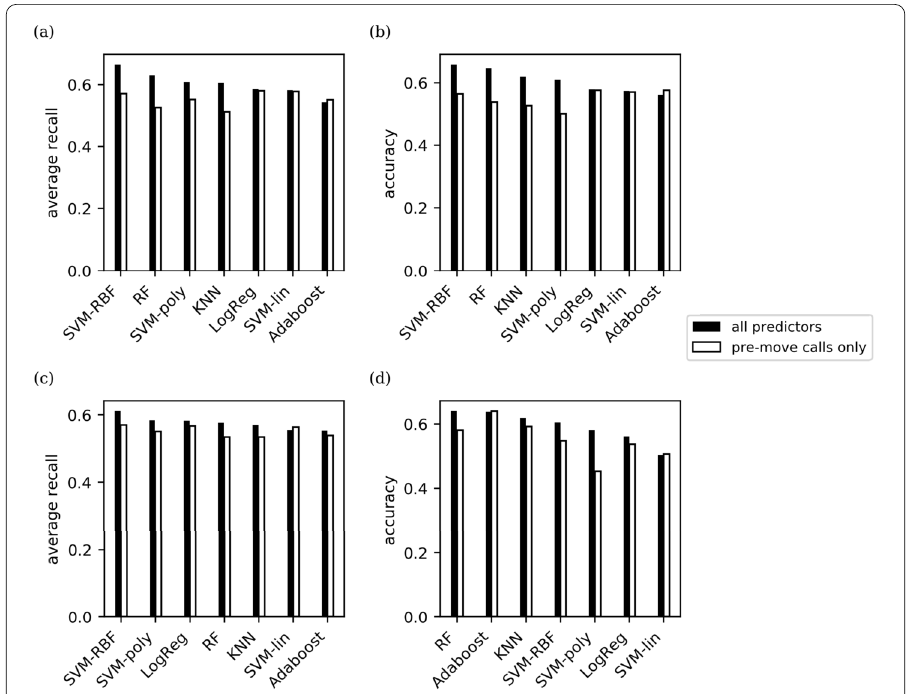
Figure 7 Classification metrics. These are the average recall and total accuracy values for predicting whether the post-move means of the number (( a ) and ( b )) and the fraction of calls (( c ) and ( d )) decay or not. The dark bars show the average recall and total accuracy for the model using all predictors, while the white bars show the same metrics for the model using only the pre-move means of the number of calls and the pre-move fraction (untransformed fraction and log-transformed